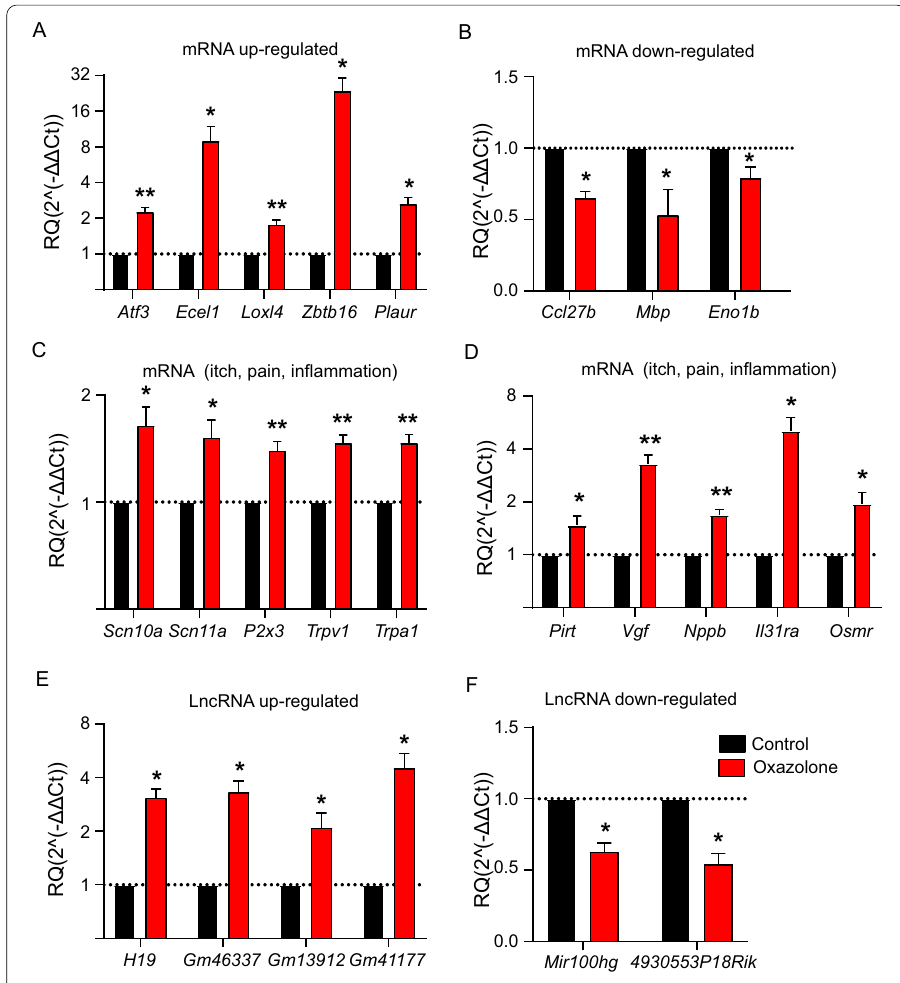
Fig. 4 Validation of DEmNRAs and DElncRNAs by qPCR testing. A Five randomly picked upregulated DEmRNAs were examined via qPCR testing. B qPCR examination of the expression of three randomly picked downregulated DEmRNAs. C , D qPCR examination of the expression of certain representative DEmRNAs relevant with itch, pain, or inflammation process. E qPCR examination of the expression of four randomly selected upregulated DElncRNAs. F qPCR examination of the expression of two randomly selected upregulated DElncRNAs. * p < 0.05, ** p < 0.01 versus control group. n 6 mice per =